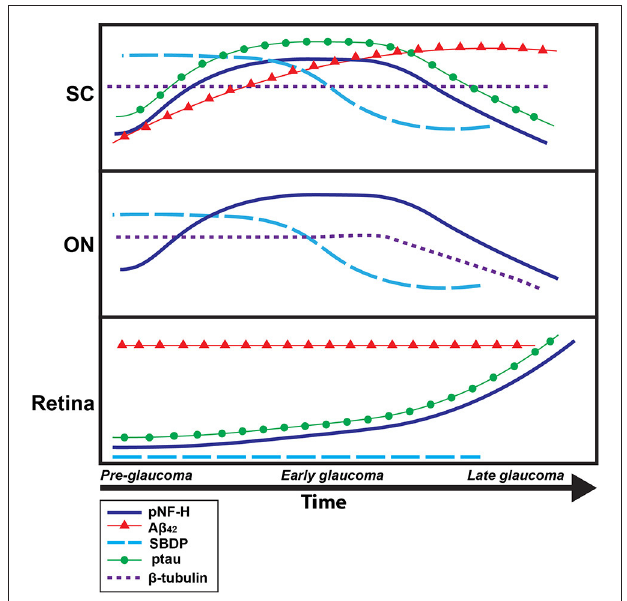
FIGURE 6 | Timeline summary of protein pathology within the DBA/2J retinal projection. A summary schematic of changes in protein levels over disease progression (pre-glaucomatous, early, and late glaucomatous ages), in the DBA/2J mouse model, for each tissue type analyzed (retina, ON, SC) is shown here. The x-axis corresponds to time while the y-axis corresponds to general protein levels. Each colored line corresponds to a specific protein: dark blue corresponds to pNF-H, red corresponds to A β 42 , light blue corresponds to SBDP, green corresponds to ptau-231, dotted purple corresponds to β -tubulin. Increased/decreased slope of each line indicates increased/decreased concentrations of each specific protein over time.